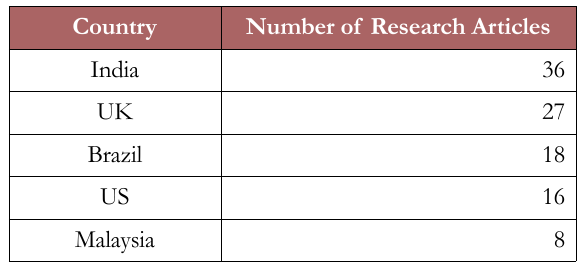
Table 4. Countries with highest number of Studies in lean